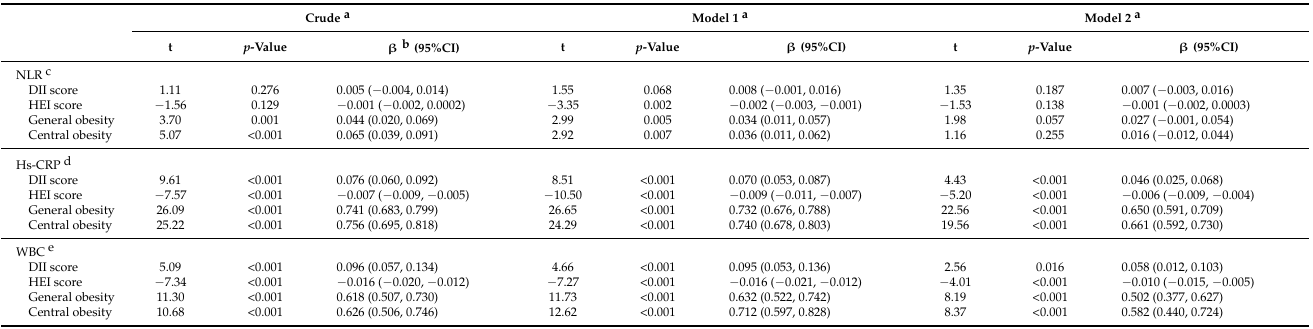
gender, race/ethnicity, education, marital status, poverty ratio, diabetes, work activities, recreational activities, hypertension, and smoking. b β : partial regression coefficient. c NLR: neutrophils/lymphocytes after logarithmic conversion; d hs-CRP: high-sensitivity c-reactive protein after logarithmic conversion; e WBC: white blood cells. Table 3. Weighted odds ratios (ORs) with 95 percent confidence intervals (CIs) for dietary quality, dietary inflammation level and obesity. Model 1 a Model 2 a